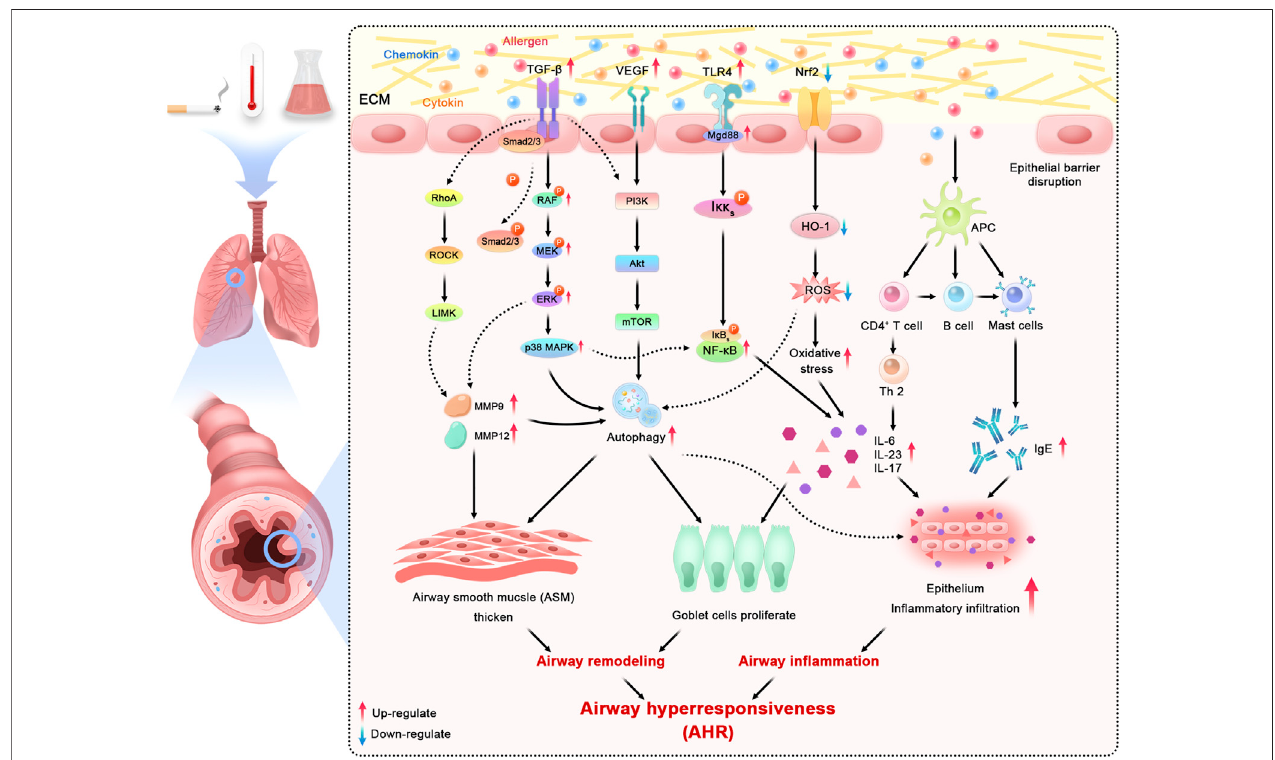
FIGURE1| Schematicoverviewofmajormechanismsandrelated signaling pathwaysinasthmaticin fl ammation andairwayremodeling(ECM:extracellularmatrix; TGF- β : transforminggrowth factor-beta; VEGF: vascular endothelialgrowth factor; TLR4: Toll-like receptor 4; Nrf2: nuclear factor erythroid-2 related factor 2; RhoA: ras homolog family member A; ROCK: rho-associated coiled-coil containing protein kinase; LIMK: LIM domain kinase; MAPK: mitogen-activated protein kinase; PI3K: phosphatidylinositol-4,5-bisphosphate3-kinase;Akt:AKTserine/threoninekinase;mTOR:mechanistictargetofrapamycinkinase;NF- κ B:nuclearfactorkappaB; HO-1: hemeoxygenase-1; ROS: reactive oxygen species; APC: antigen presenting cell; MMP: matrix metallopeptidase; IL: interleukin; IgE: immunoglobulin